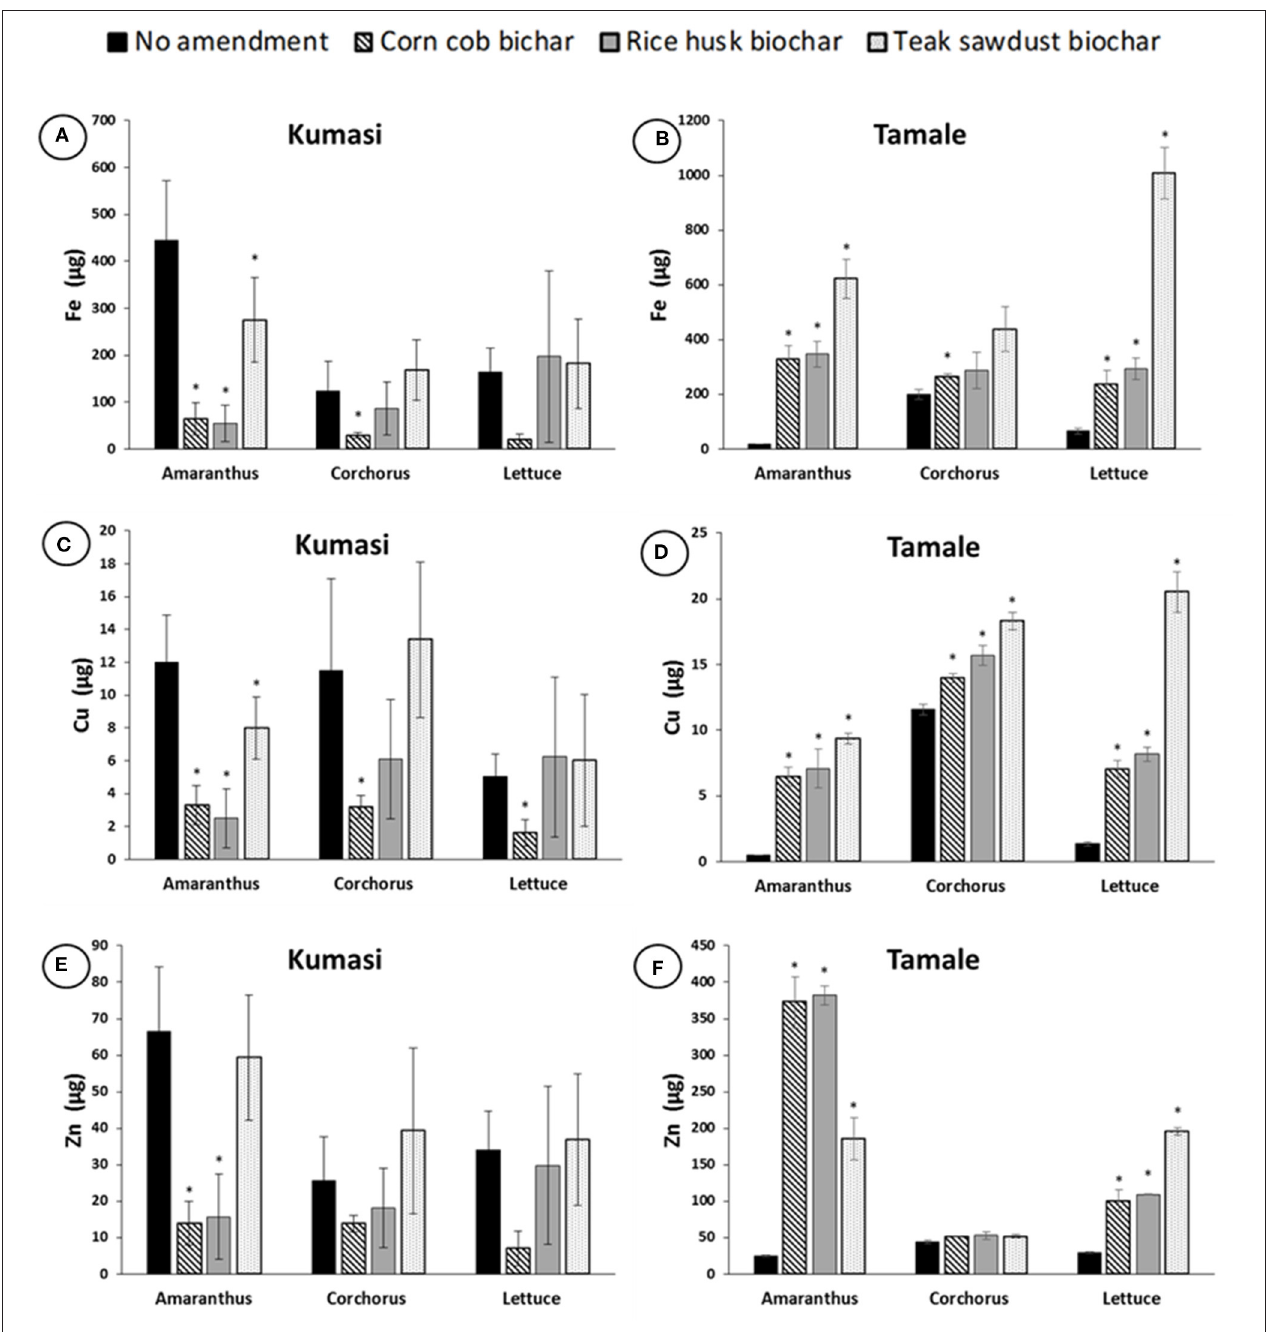
FIGURE 6 | Plant uptake of Fe, Cu, and Zn into Amaranth, Corchorus, and Lettuce in Kumasi (A,C,E) and Tamale (B,D,F) soils amended with 5% (w/w) corn cob biochar, rice husk biochar, or teak sawdust biochar. Data with asterisks are statistically significantly different from control for each crop ( p < 0.05). Error bars represent standard deviation n =